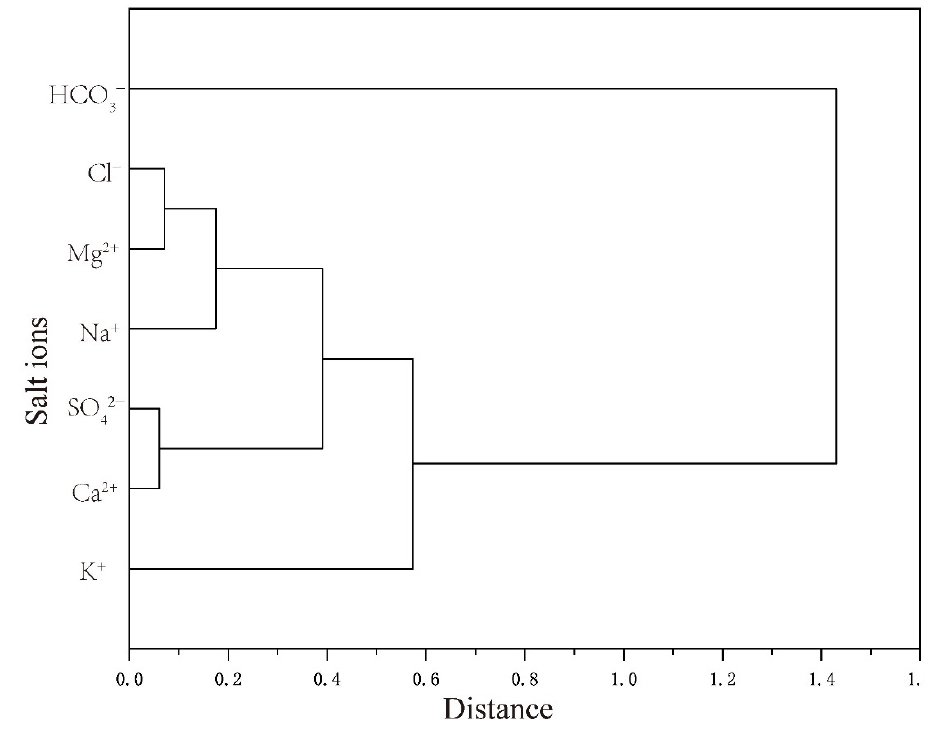
Figure 6. Soil salinity variable cluster analysis diagram.